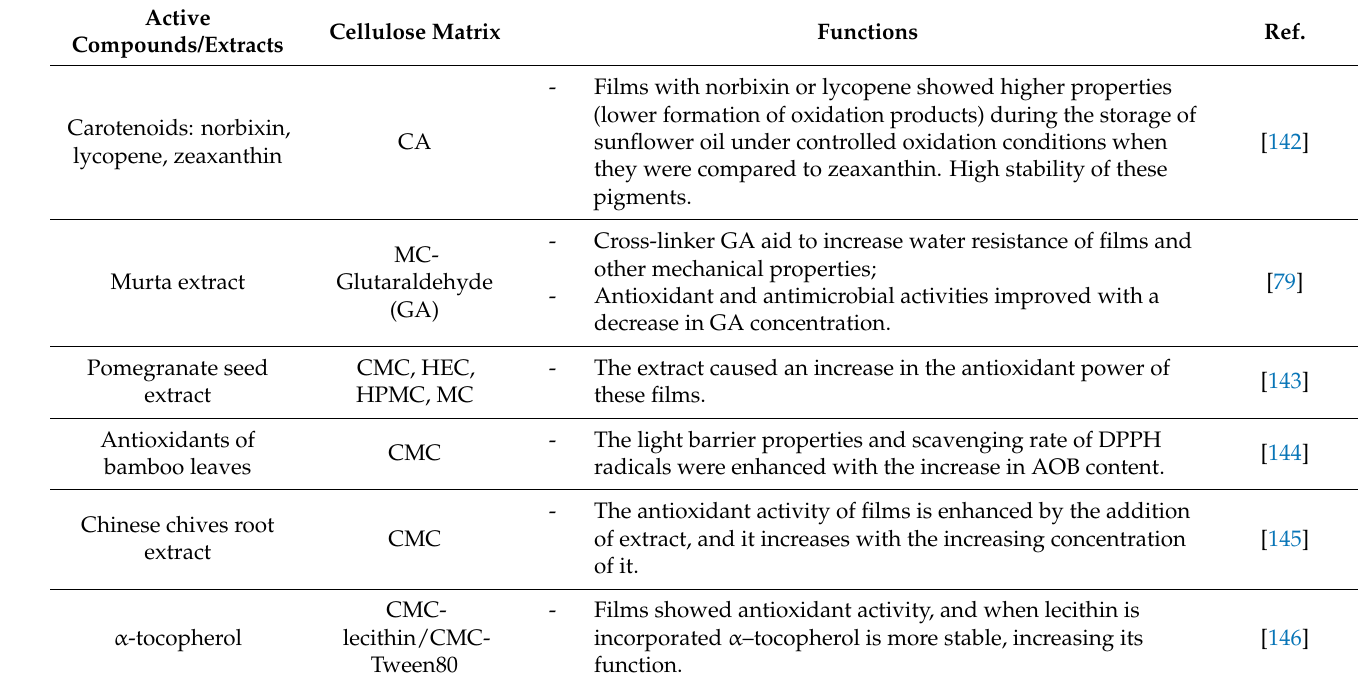
Table 2. Summary of antioxidant cellulose films functionalized with active compounds/extracts, showing beneficial properties for food